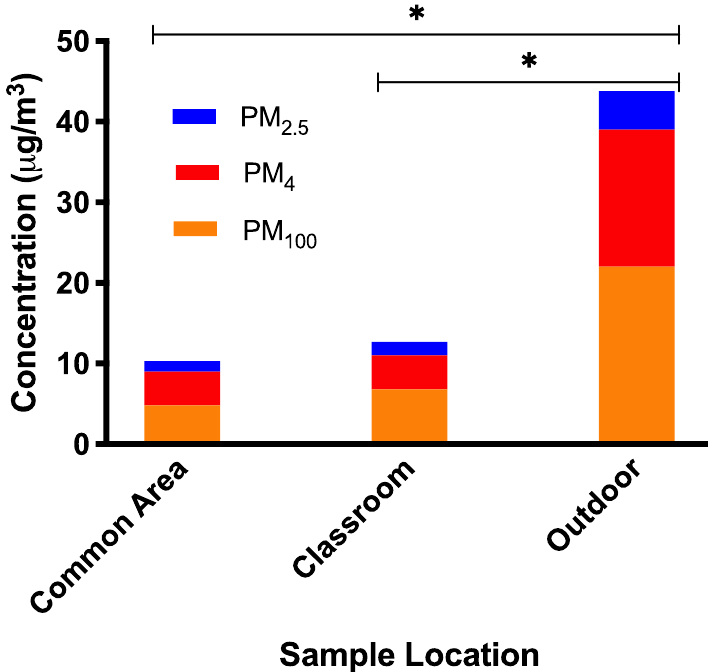
Figure 2. Average PM concentrations by size-fraction observed in each sample location. Stacked bar graph of unoccupied and occupied PM 100 , PM 4 , and PM 2.5 concentrations by sample location. Outdoor concentrations at PM 100 (bottom bar), PM 4 (middle bar), and PM 2.5 (top bar) were significantly higher (* signifies significance at p -value < 0.05) than concentrations in the other two sample locations.